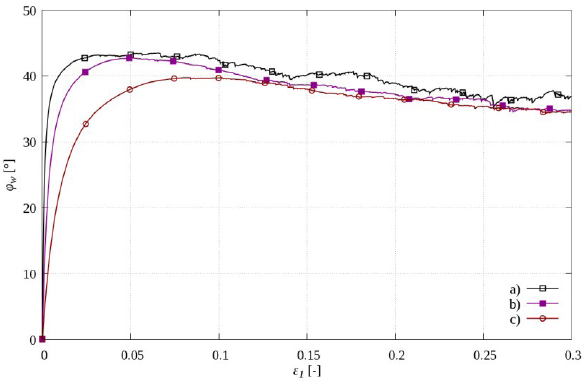
versus vertical normal strain ε w 1 = 50 kPa, b) σ = 200 kPa 0 0